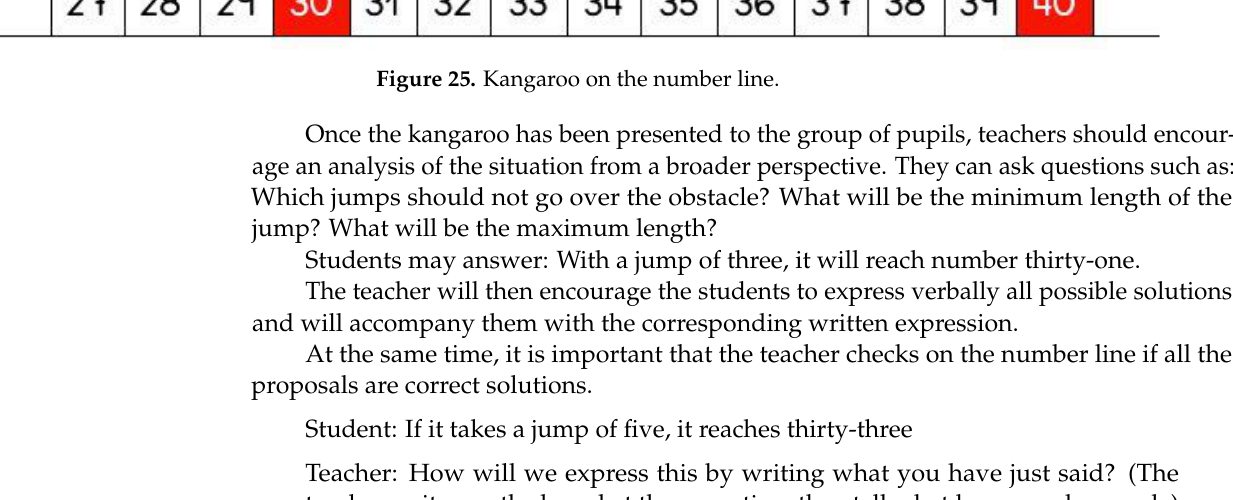
Figure 25. Kangaroo on the number line.